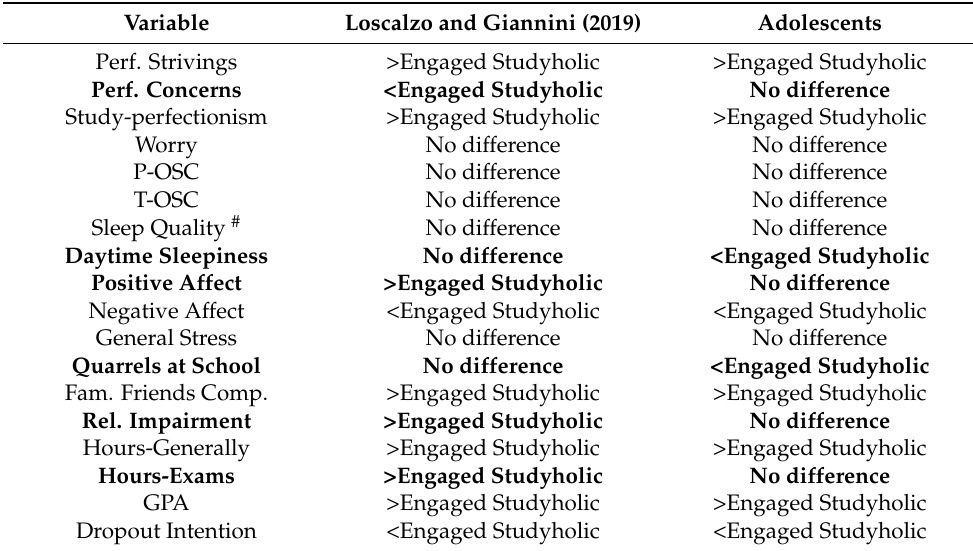
Table 5. Differences between Studyholic types. A comparison with Loscalzo and Giannini’s [5] results.